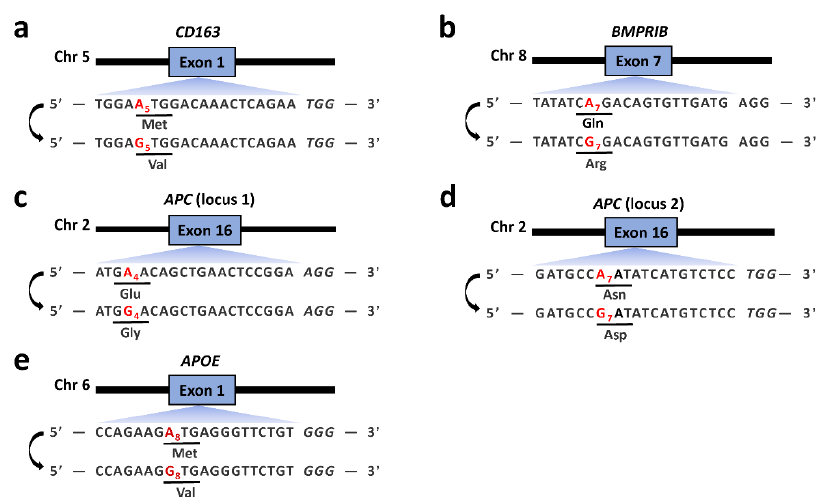
Figure 1. The target sequences at CD163 ( a ), BMPRIB ( b ), APC (locus 1) ( c ), APC (locus 2) ( d ) and APOE ( e ). The desired A-to-G conversion at each locus is marked in red.